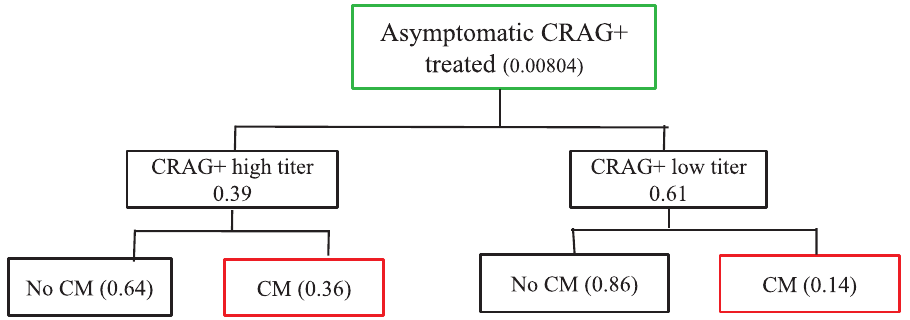
Fig 5. Treatment of Asymptomatic CrAg positive persons within the HIV test & treat